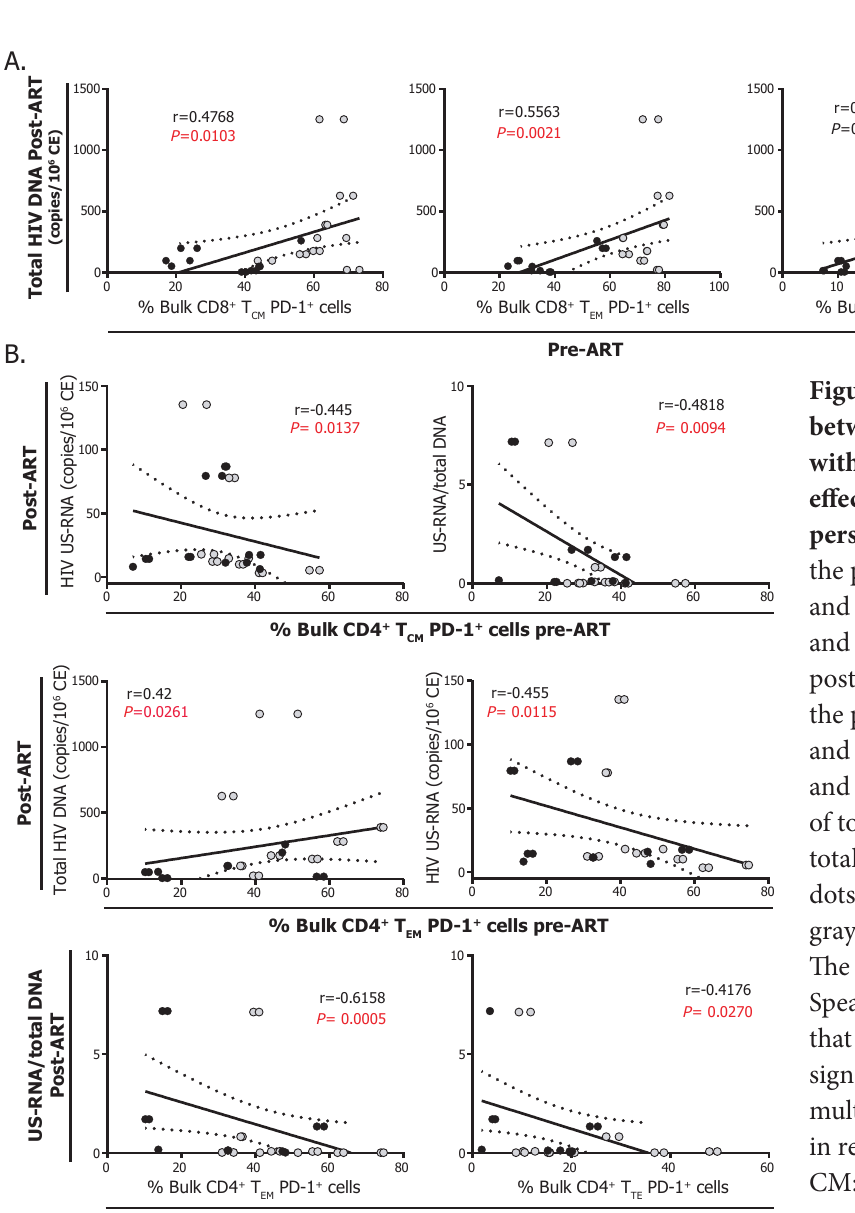
Figure 4: Correlation analysis between the expression of PD-1 within CD4+ and CD8+ memory/ effector subpopulations and HIV persistence A. Correlations between the percentages of CD8+ T , T , CM EM and T expressing PD-1 pre-cART TE and the levels of total HIV DNA post-cART. B . Correlations between the percentages of CD4+ T , T , CM EM and T expressing PD-1 pre-cART TE and the levels of US-RNA, the levels of total HIV DNA, and US-RNA/ total DNA ratios post-cART. Black dots represent ET participants and gray dots represent DT participants. The r and P values correspond to Spearman’s test. Those correlations that remained statistically significant after correction for multiple comparisons are shown in red. SCM: stem-cell memory, CM: central memory, EM: effector memory, TE: terminal